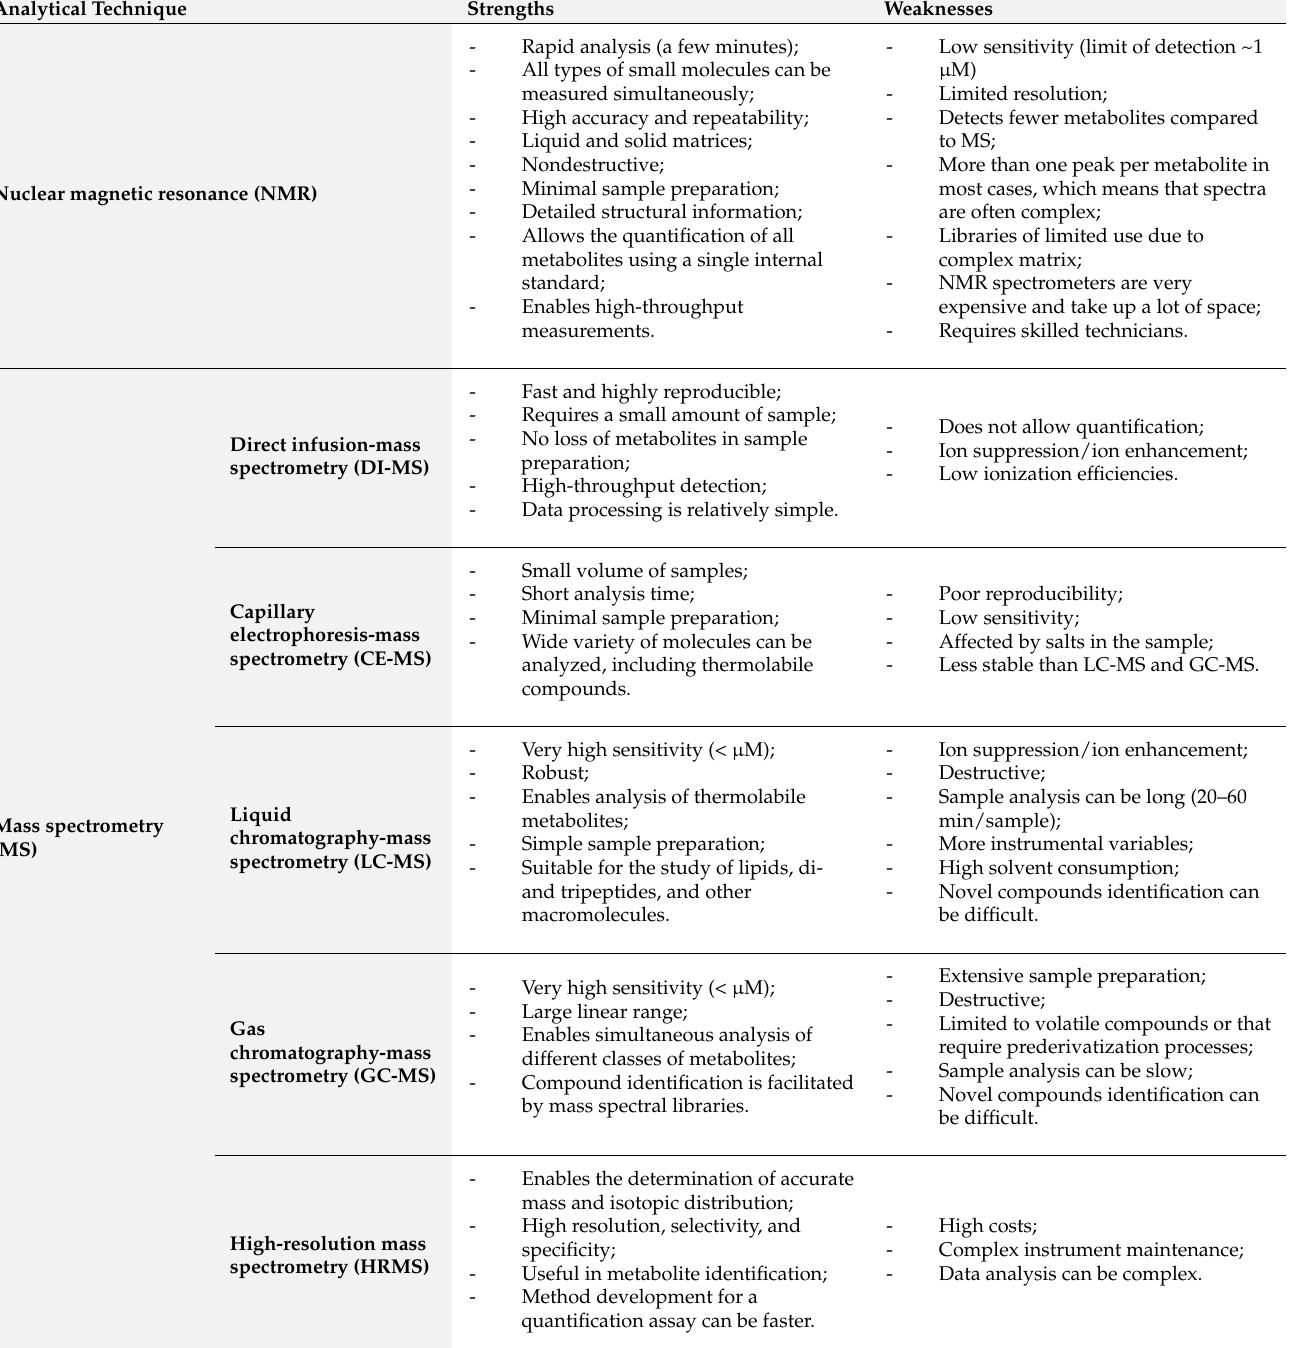
Table 2. A summary of the most relevant characteristics of the analytical techniques commonly used in metabolomics [1,16,63,85–87,91–93]. Analytical